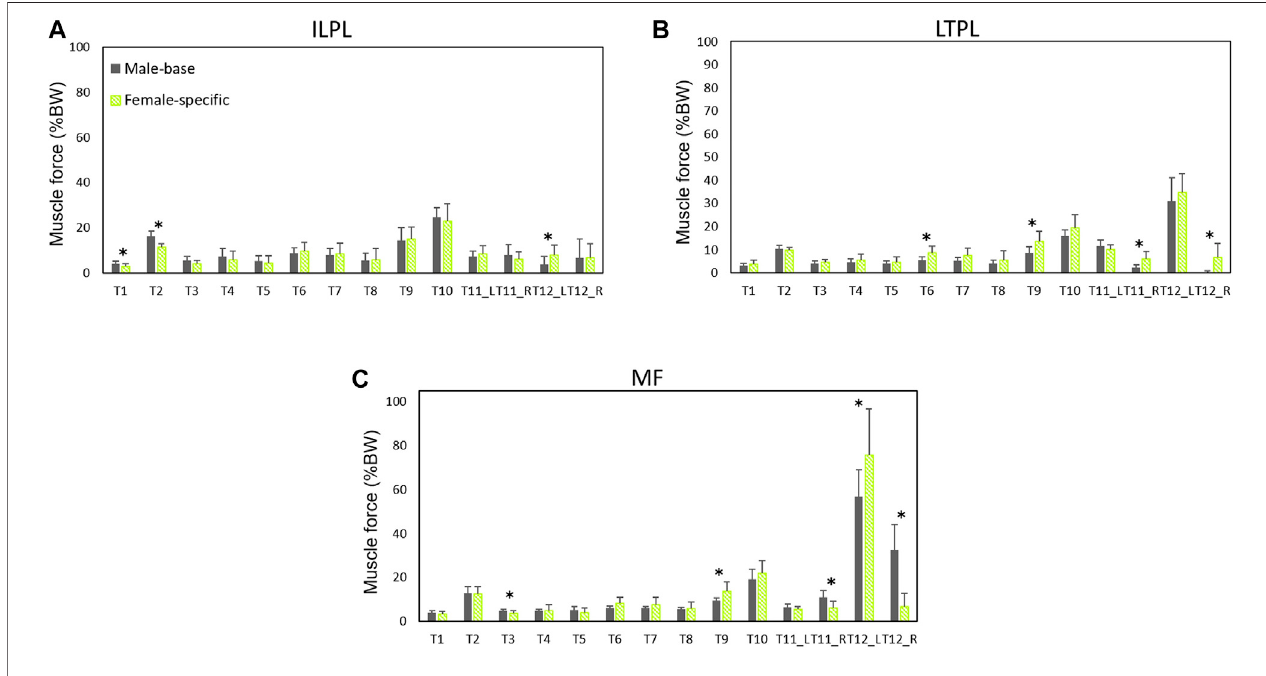
FIGURE6 | Local muscle forces (average of left and right) aspredictedby males ’ models and female-speci fi cmodels: (A) iliocostalis lumborum pars lumborum (ILPL), (B) longissimus thoracis pars lumborum (LTPL), and (C) multi fi dius (MF). * indicates a signi fi cant difference ( p < 0.05) between males and females.